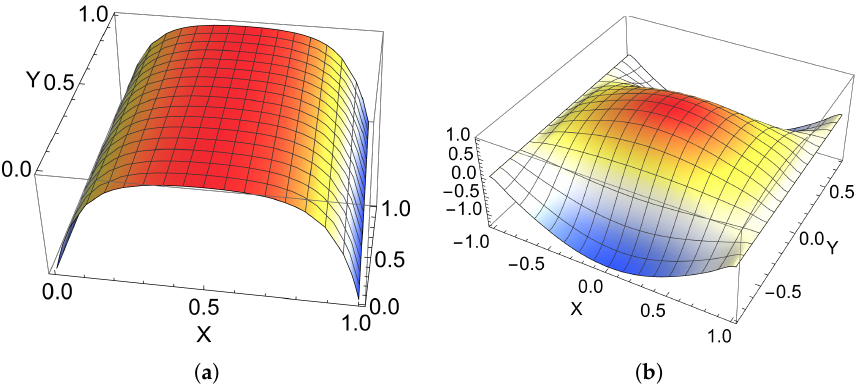
Figure 1. Solutions of model problems. In elasticity problems, the strongest boundary layers may occur in other vector field components. ( a ) Reaction–diffusion. ( b ) Pitkäranta Cylinder. Detail of transverse deflection (one quarter of the cylinder